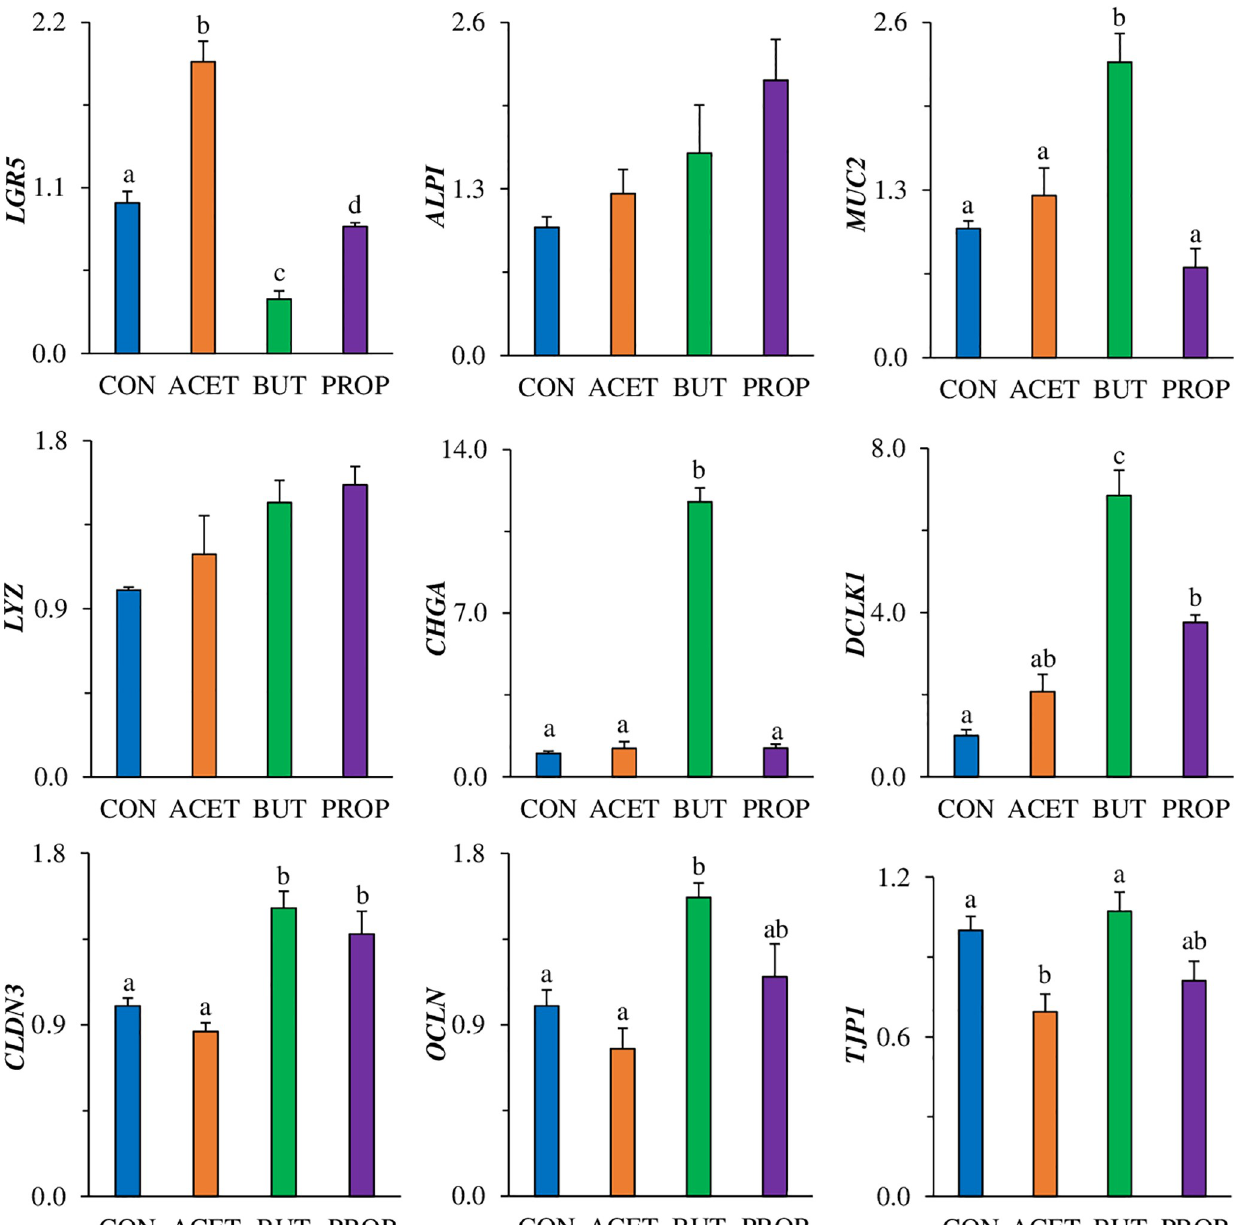
Fig 6. Effect of 24 h treatment with acetate (ACET), butyrate (BUT), or propionate (PROP) at 10 mM. Gene expression of differentiation markers: stem cells ( Lgr5) , enterocyte alkaline phosphatase ( Alpi ), goblet cell mucin 2 ( Muc2 ), enteroendocrine cell chromogranin A ( Chga ), Paneth cell lysozyme ( Lyz ), tight junction markers claudin-3 ( Cldn3 ), occludin ( Ocln ), zonula-occludens 1 ( Tjp1 ), Tuft cell marker Dclk1 , anti-microbial peptide expression Reg3 β , Reg3 γ , and beta-defensin 1 ( Defb1 ) were analyzed in human 2D duodenal enteroids. Treatments are compared to controls (CON) which are set to 1.0 and superscripts (a,b,c,d) indicate statistical significance between treatments at P < 0.05, n =